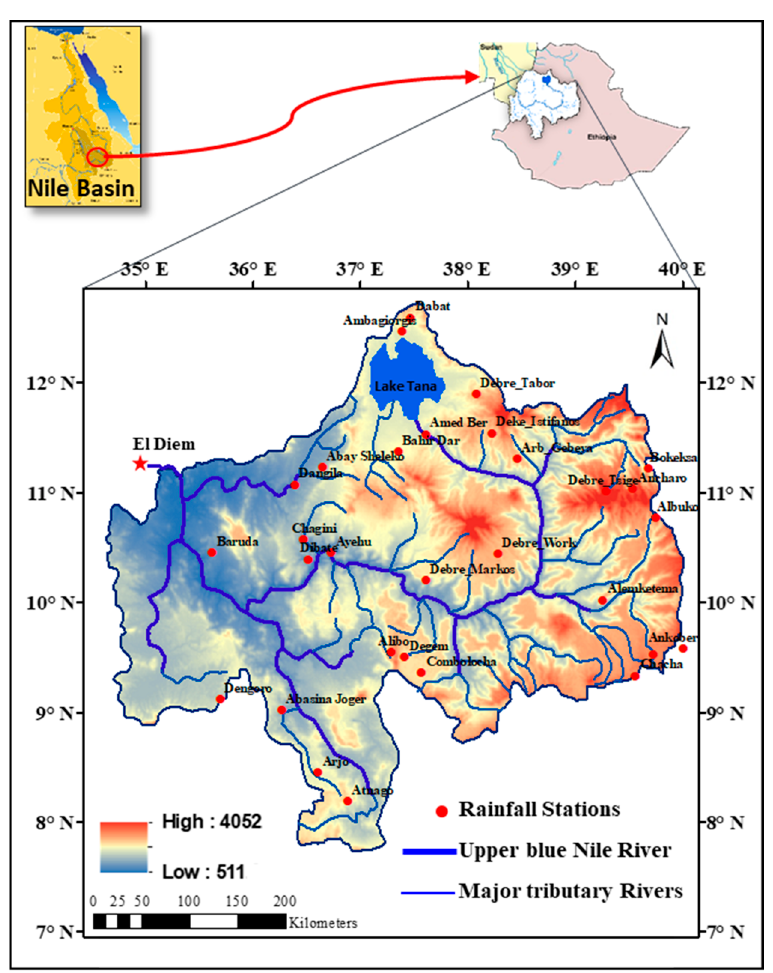
Figure 1. Location map of the study area showing the digital elevation model (DEM) of the upper Blue Nile River basin and the selected meteorological stations.